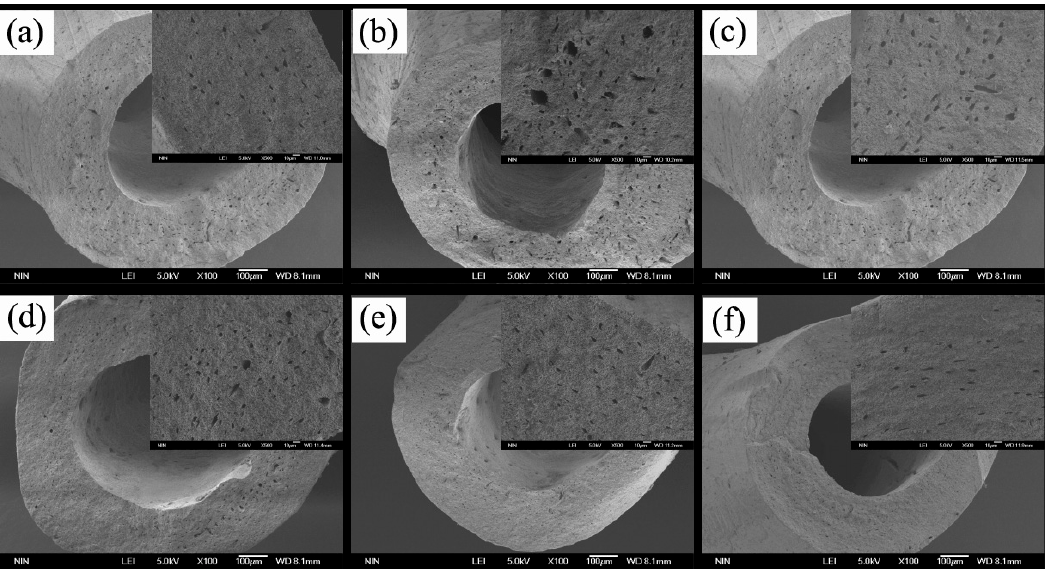
Figure 10. SEM images of the section of tibia from osteoporosis mice that supplement calcium for 12 weeks. ( a ) Control group; ( b ) Ca-deficiency group; ( c ) Empty CS/ALG group; ( d ) Col-Ca group; ( e ) PHLC-Ca group; ( f ) CS/ALG-(PHLC-Ca) group.